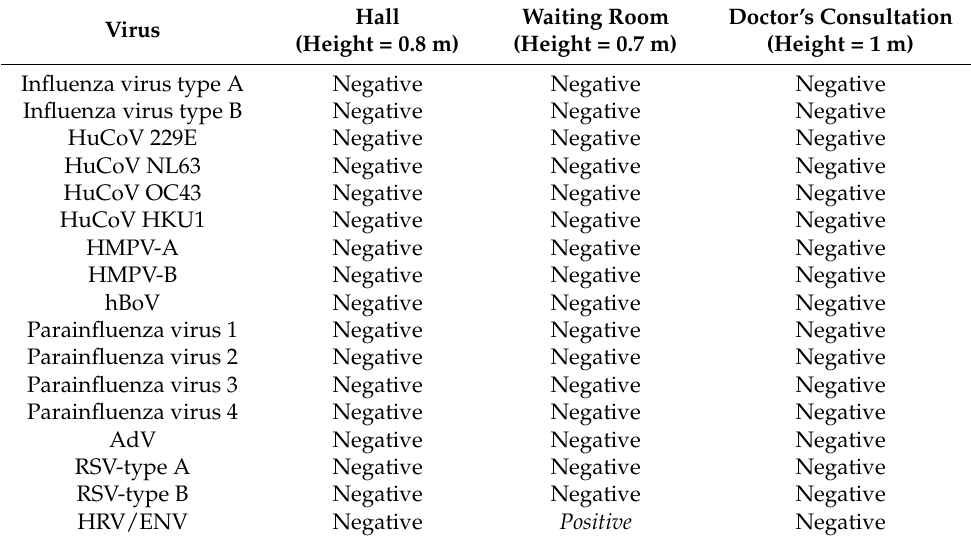
Table 1. Obtained results for respiratory virus in the indoor